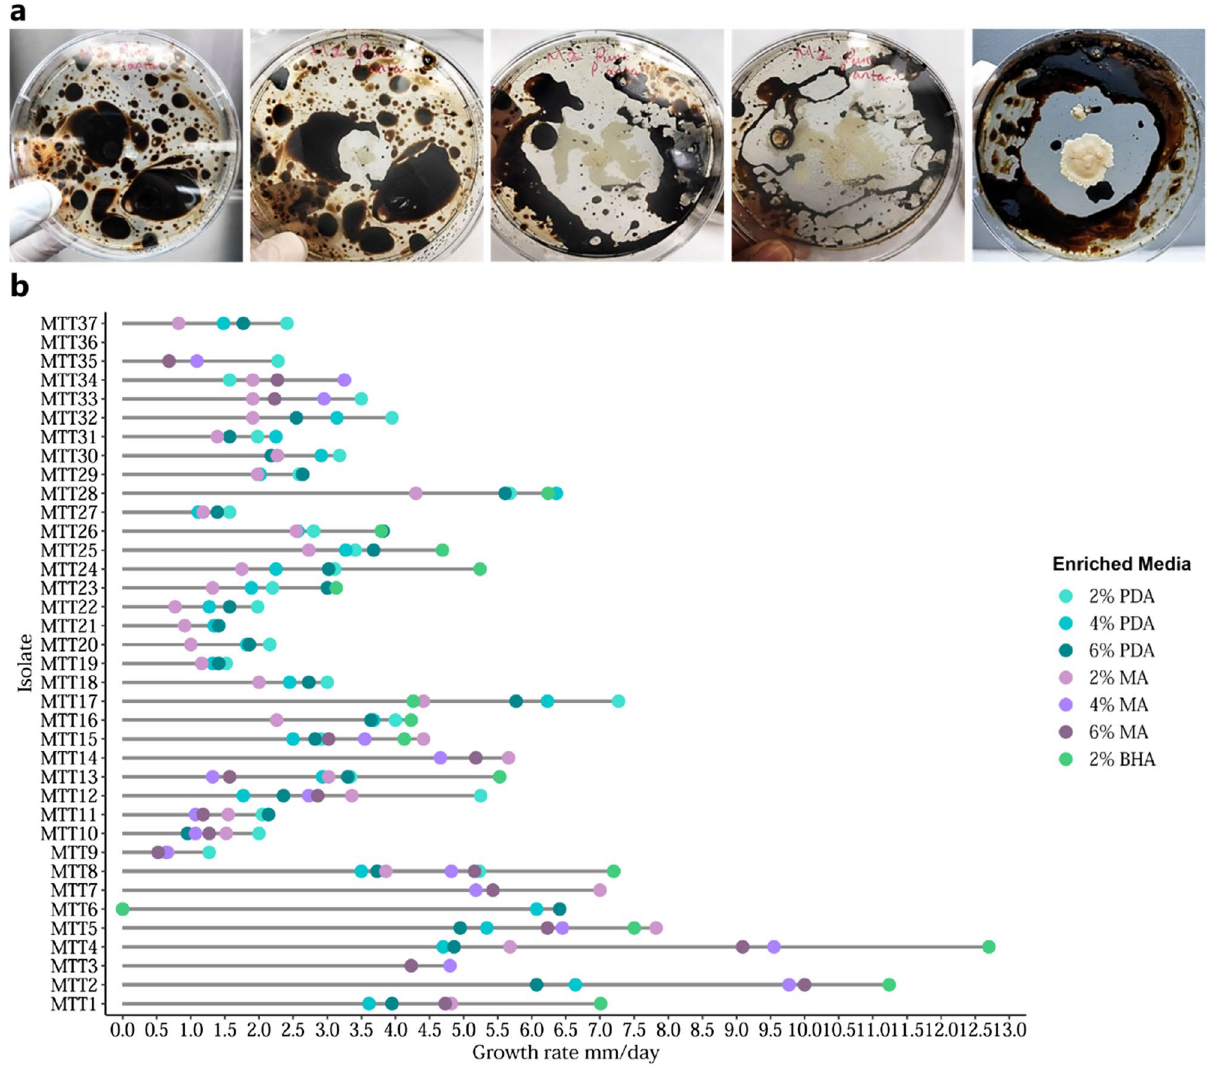
Figure 1. Growth on oil-amended media. ( a ) Performance of yeast-bacterium co-culture on crude oil enriched media; left to right 2% oil plates after 0, 24, 48, 72 h and 4% oil plate after 72 h. ( b ) Growth rate on respective crude oil enriched media (RStudio software